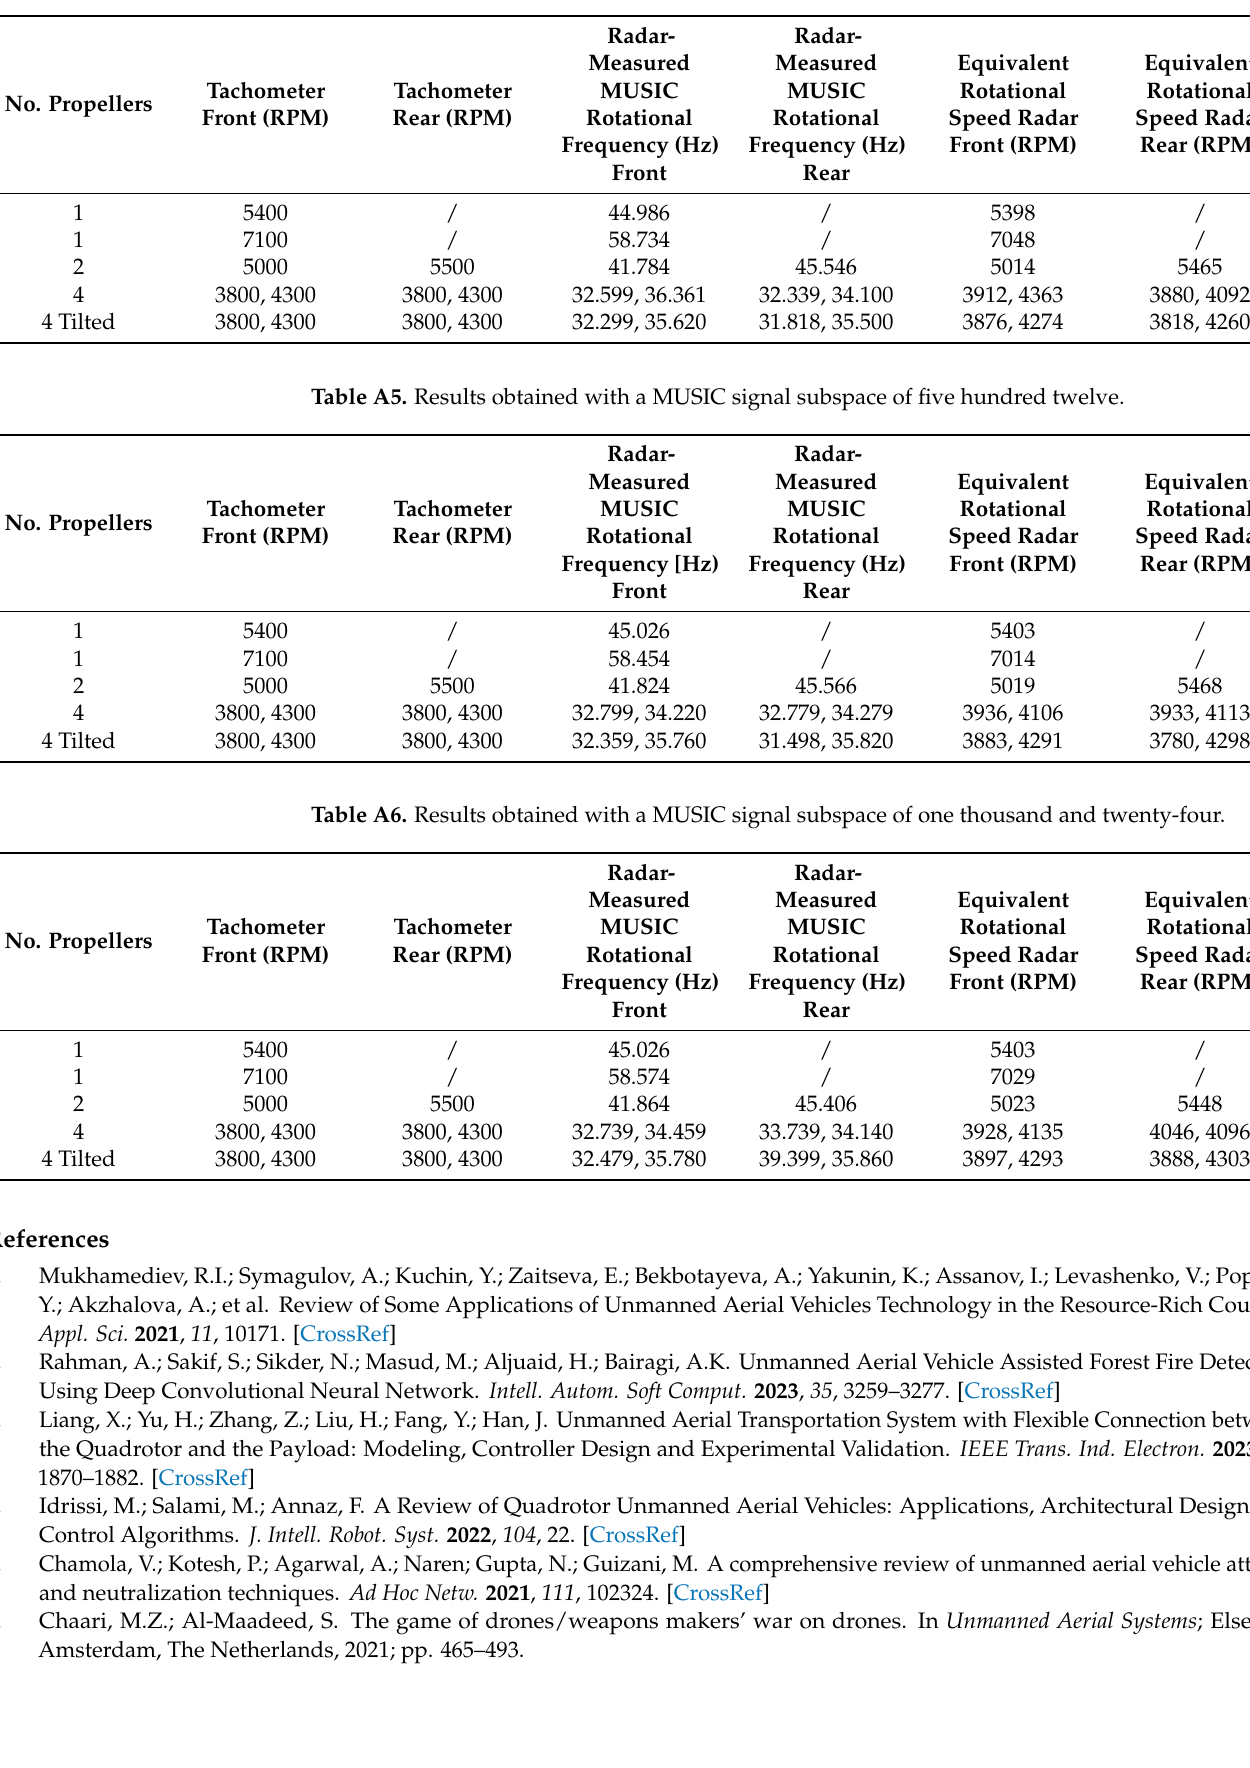
Table A4. Results obtained with a MUSIC signal subspace of two hundred and fifty six.